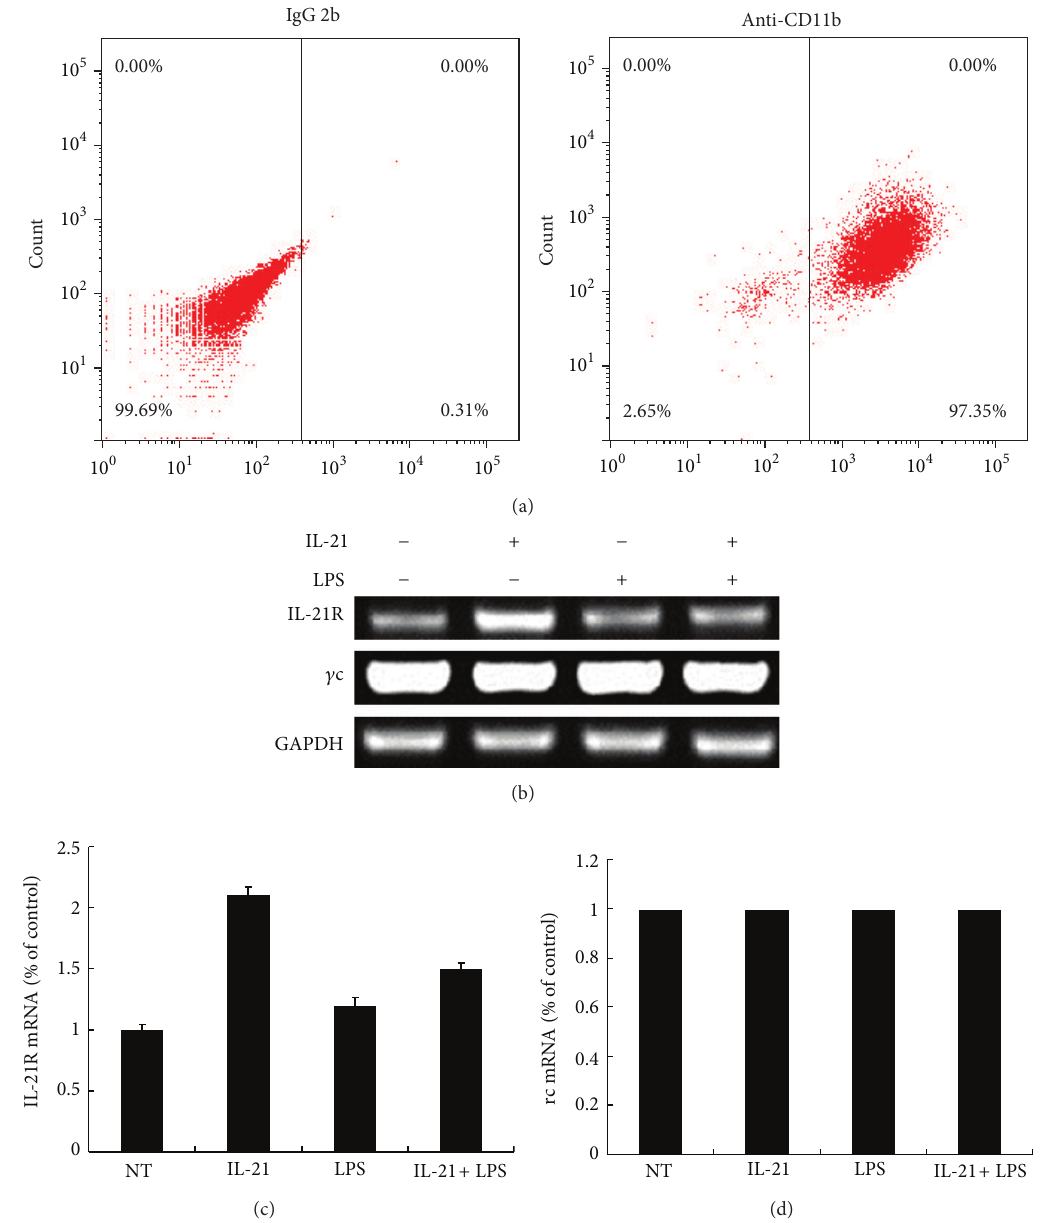
Figure 1: Effects of IL-21 on LPS-induced IL-21R and 𝛾 c mRNA expression in mouse peritoneal macrophages. Mouse peritoneal macrophages were incubated with IL-21 (100ng/mL) in the presence or absence of LPS (100ng/mL) for 6h. Macrophages were stained with IgG2b and CD11b antibodies (a). Total RNA was isolated and analyzed by real time RT-PCR for IL-21R (c) and 𝛾 c (d). IL-21R and 𝛾 c expression was normalized to endogenous control GAPDH. Results are expressed as mean ± SD for each group from three independent experiments.